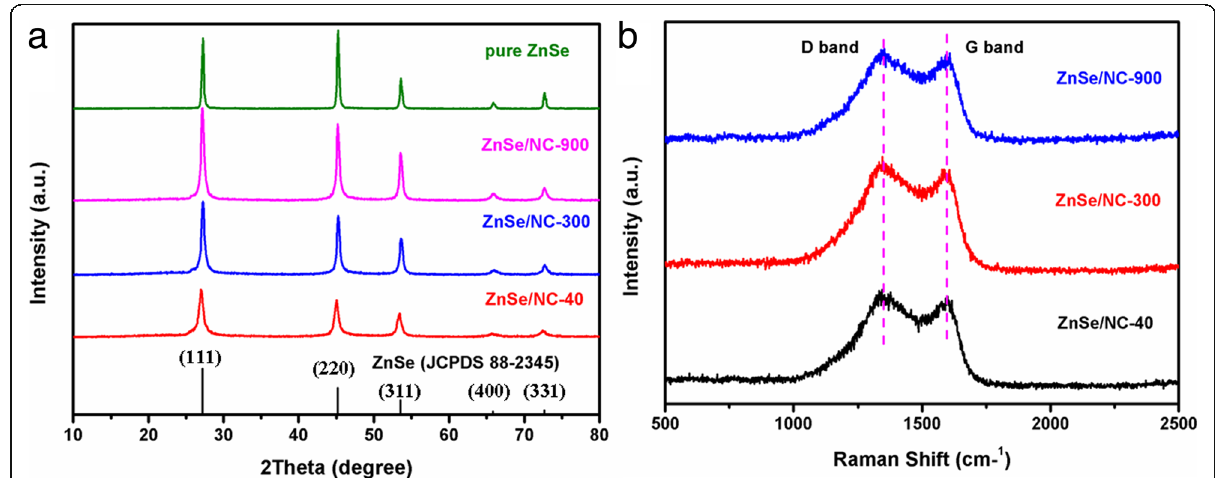
Fig. 2 a The XRD patterns of pure ZnSe, ZnSe/NC-900, ZnSe/NC-300, and ZnSe/NC-40. b Raman spectrum of ZnSe/NC-900, ZnSe/NC-300, and